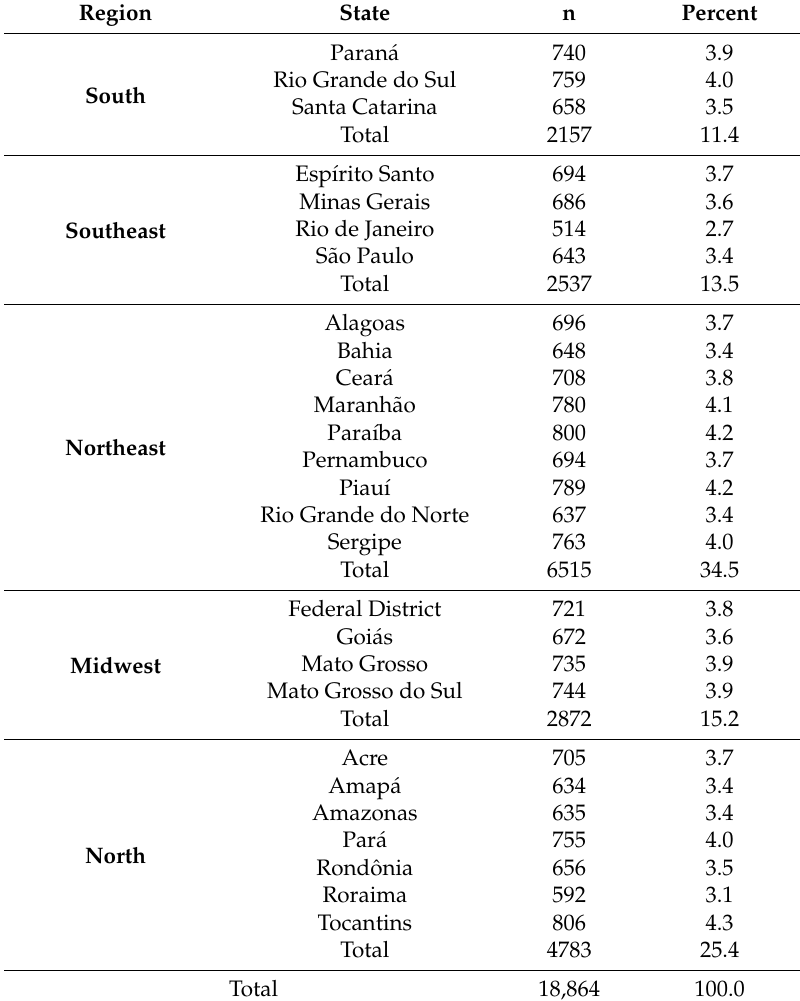
Region State n Paran